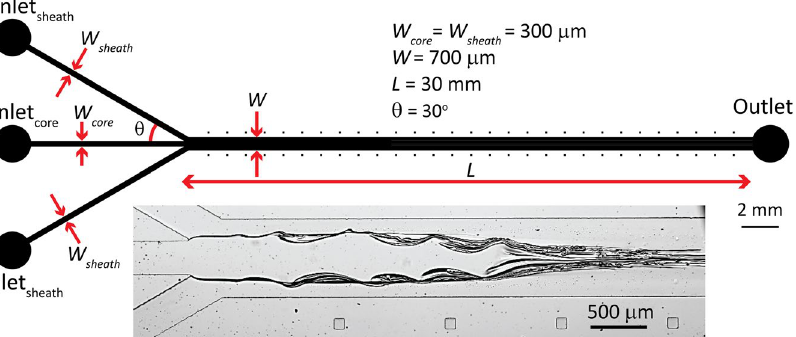
Figure 1. Schematics of the microfluidic flow focusing system. Inset shows the formation of the glycerol core flow between water sheath